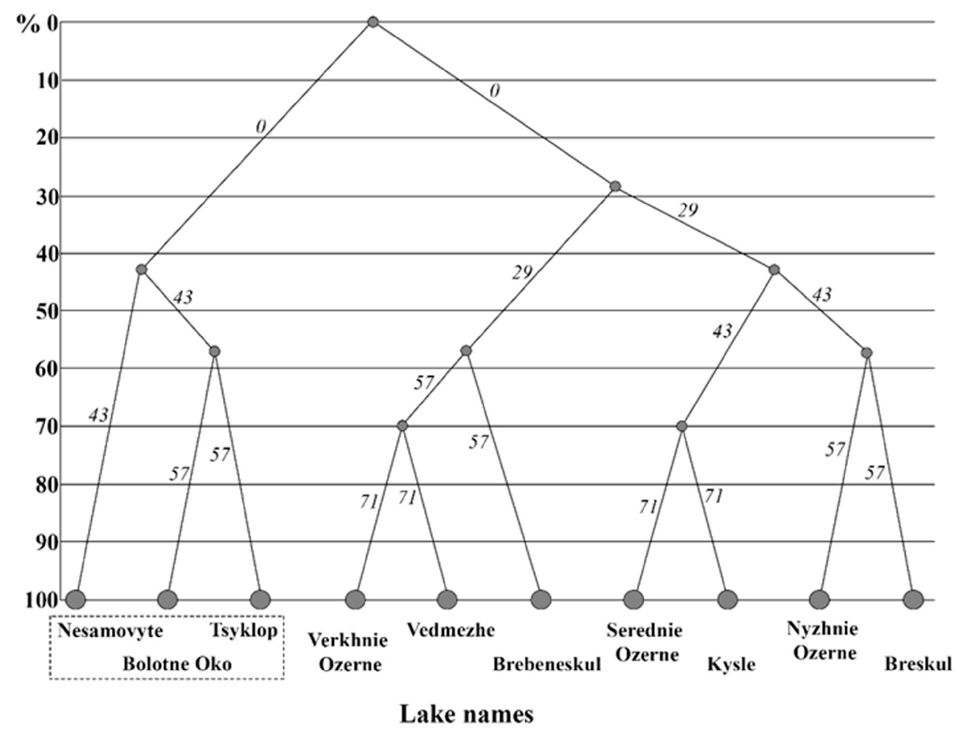
Figure 5. Dendrogram of floristic similarity of species composition of algae in the Nesamovyte Lake with regionally close lakes of the Chornogora mountain group (Jaccard coefficient).